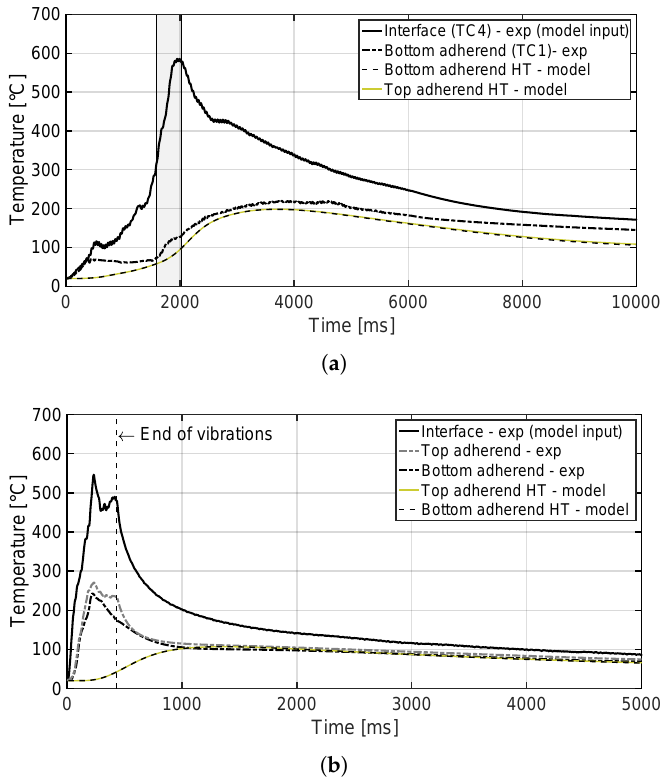
Figure 10. Modelled through-the-thickness temperature evolution due to heat transfer (HT) as a result from experimental (exp) temperature input at the weld interface for ( a ) the continuous and ( b ) static temperature evolution together with a representative experimental temperature evolution as a reference. The grey area ( a ) and the vertical line ( b ) indicate the time span during which the thermocouples were located under the sonotrode. Note that in ( a ) no experimental temperature evolution for the top adherend is shown as it was deemed less trustworthy due to severe overheating.